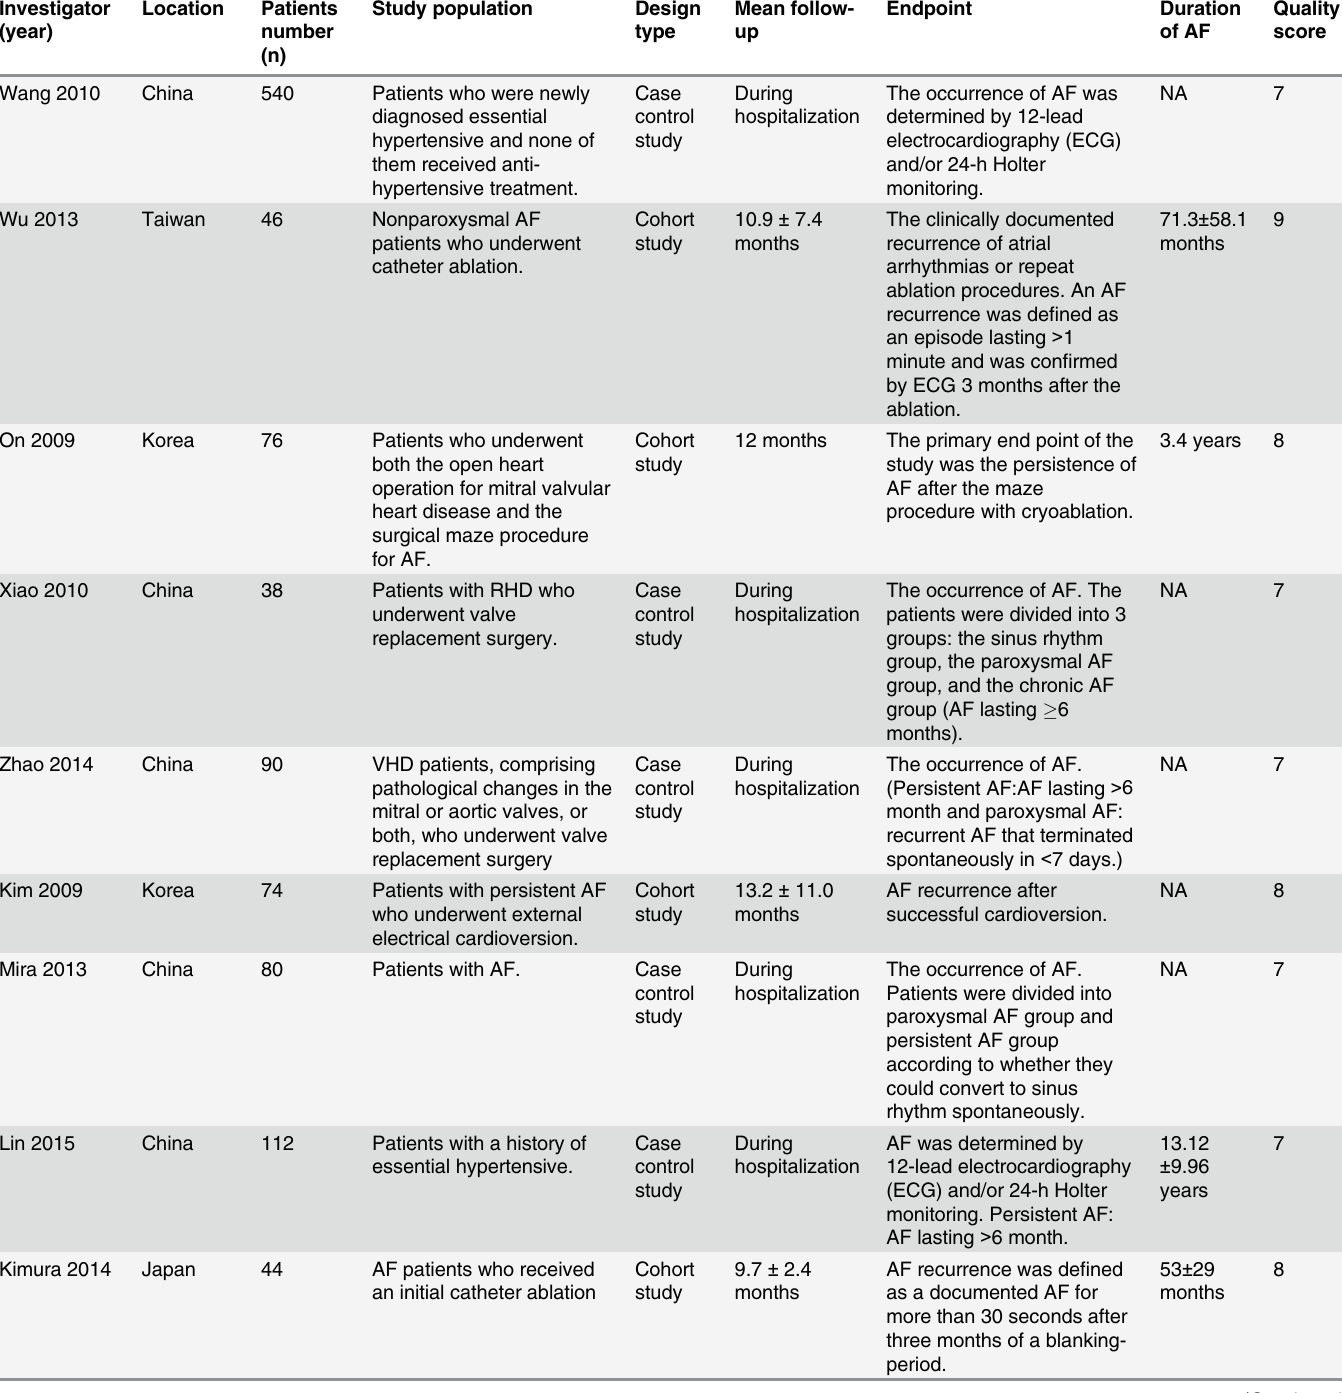
Table 1. General data of studies included in